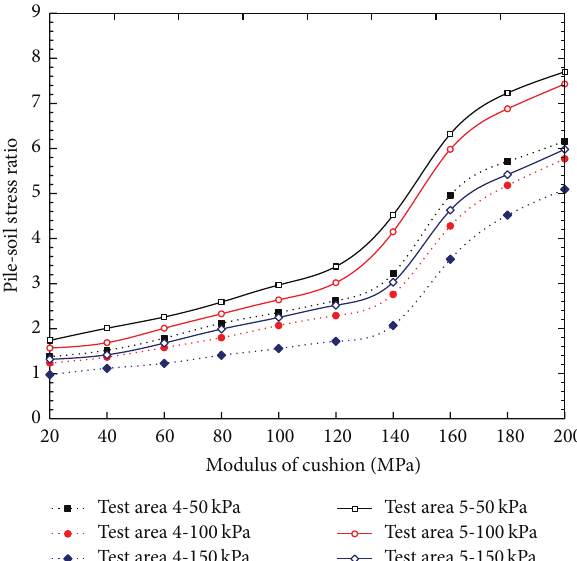
Figure 19: Effect of cushion thickness on pile-soil stress ratio.